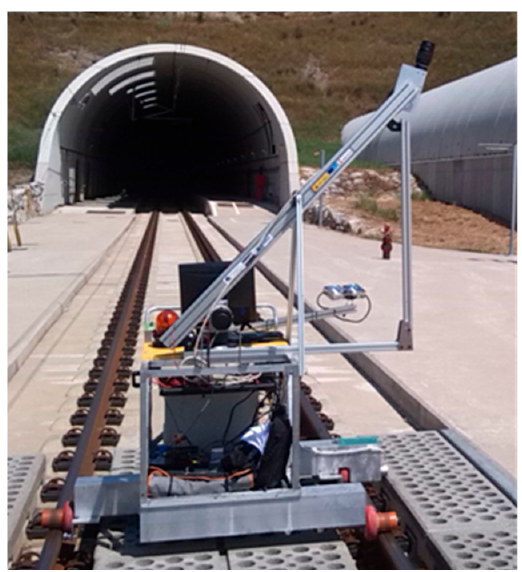
Figure 5. Prototype of the tunnel inspection platform.